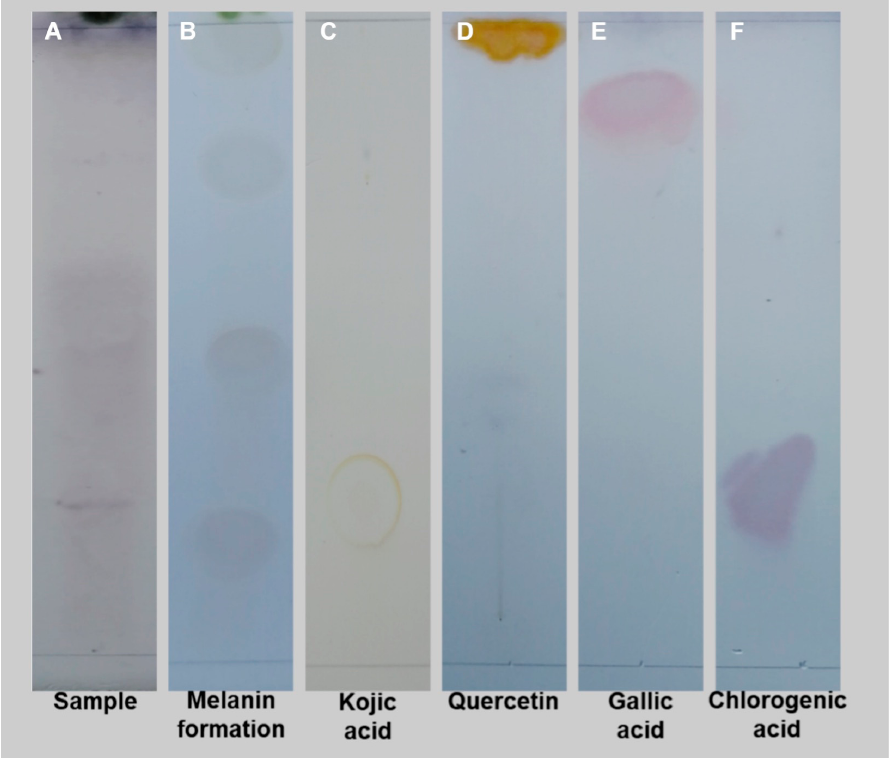
Figure 1. Tyrosinase-based TLC autography activity assay. Column A (untreated sample), column B (melanin formation), column C (kojic acid), column D (quercetin), column E (gallic acid) and column F (chlorogenic acid).